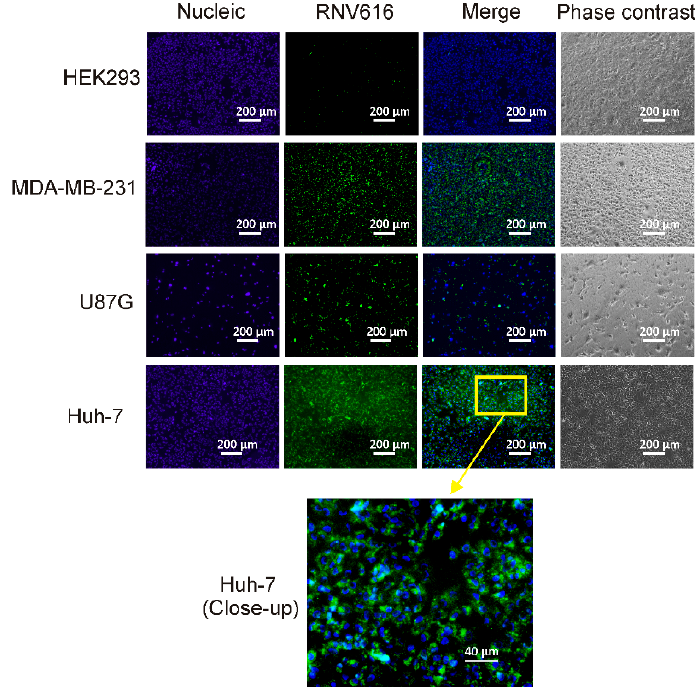
Figure 5. Specific binding of CL-4RNV616 aptamer to EGFR-positive cells. CL-4RNV616 aptamer specifically binds to EGFR-positive Huh-7, U87MG, and MDA-MB-231 cells but not to EGFR-negative HEK293 cells. Cells were imaged via fluorescent microscopy after incubation with 200 nM of aptamer at 37 °C for 30 min. Green, FAM (aptamer), and blue, Hoechst 33342 (nuclei).